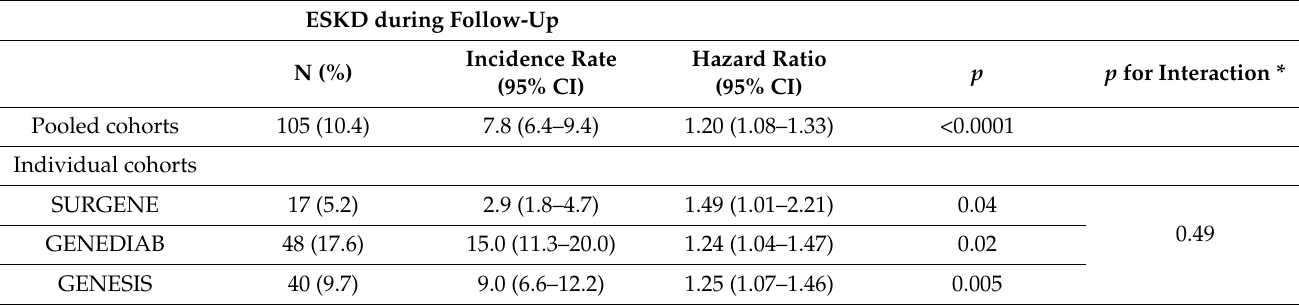
Table 3. Risks of ESKD during follow-up by redox genetic risk score, considered as continuous variable, in each individual